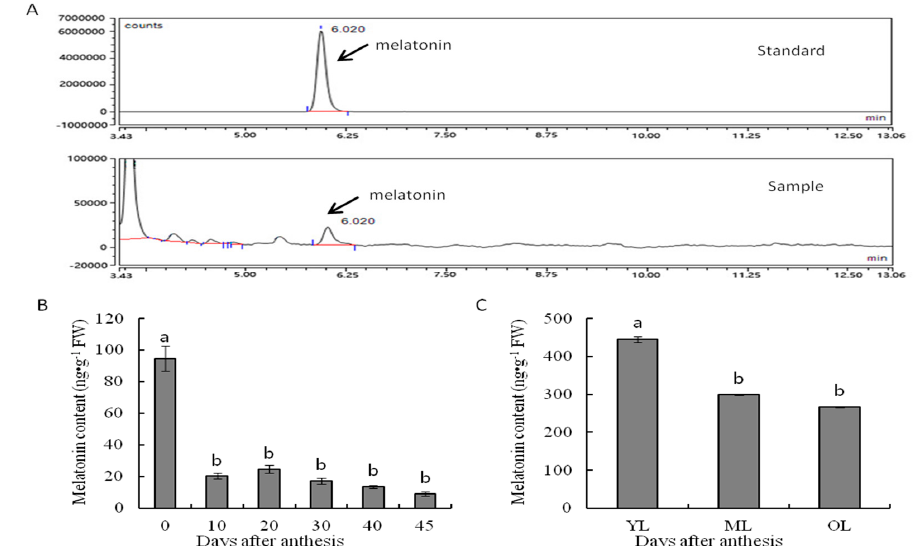
Figure 1. ( A ) HPLC chromatogram for melatonin and its concentrations in ( B ) fruit and ( C ) leaves of Hongdeng. YL: young leaves; ML: mature leaves; OL: old leaves. Data are shown as mean ± SE with five biological replicates, di ff erent letters indicate significant di ff erences at p < 0.05